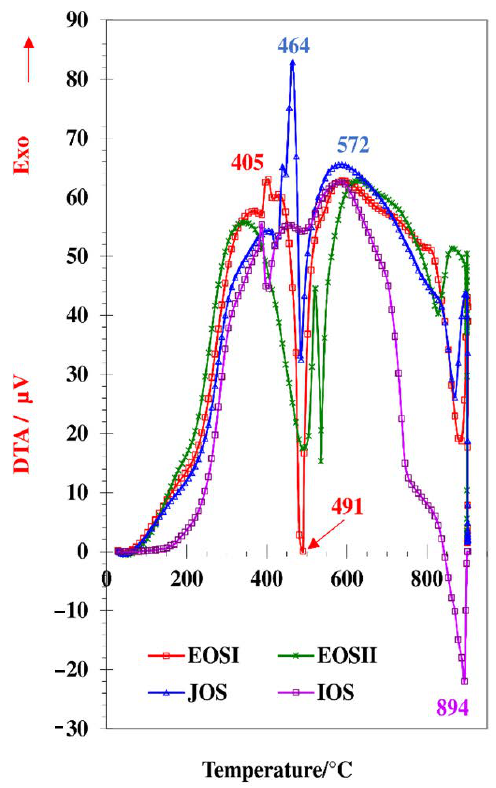
Figure 2. Differential thermal analysis (DTA) curves for different oil shales (50 ◦ C min − 1